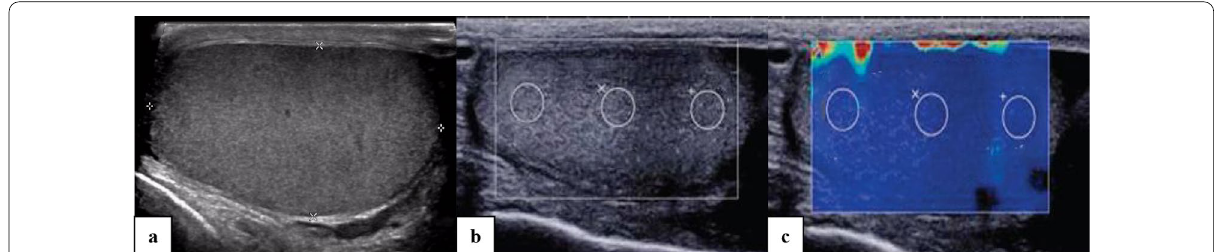
Fig. 1 A 30-year*old normospermic male patient. a High-resolution ultrasound showed normal sonographic features of the Lt. testicle without evidences of testicular varicocele. b , c Shear wave ultrasound elastography images of the Lt. testicle displayed homogenous blue color with mean testicular stiffness value 3.4 kPa =